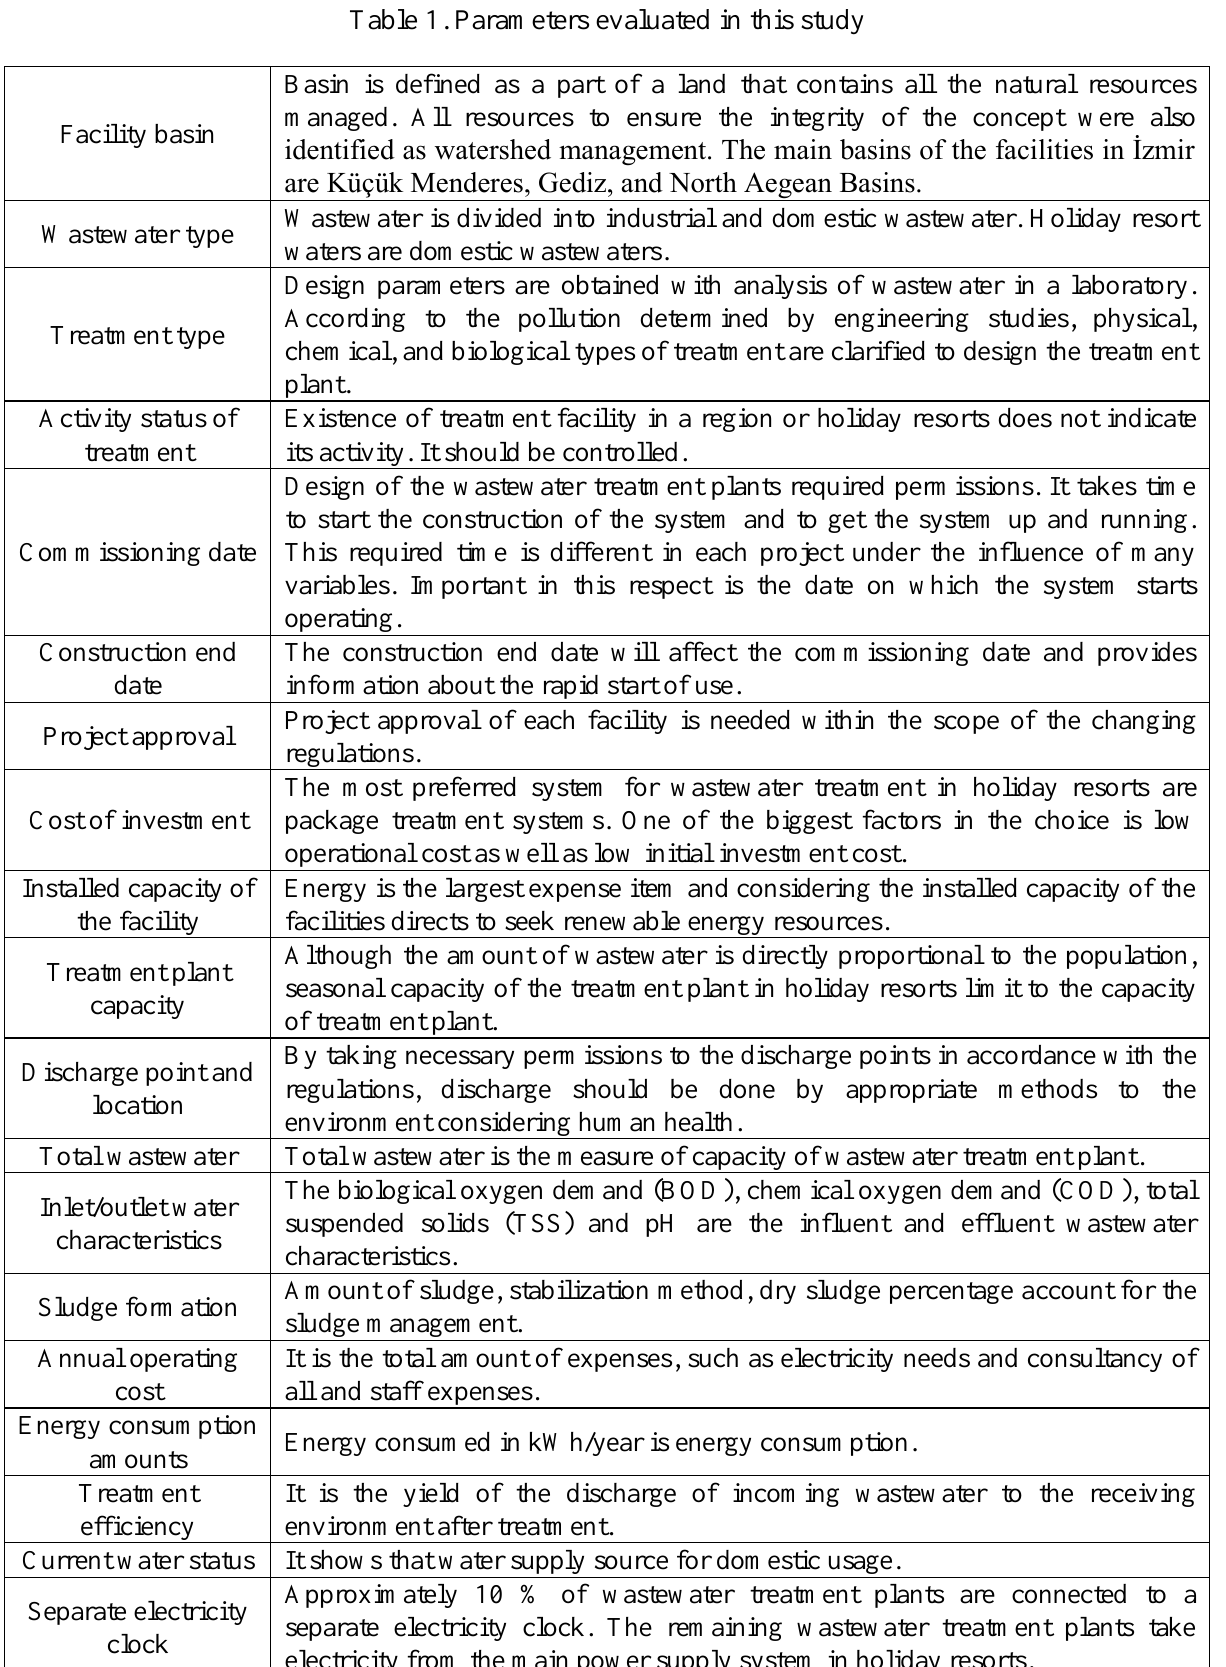
Table 1. Parameters evaluated in this